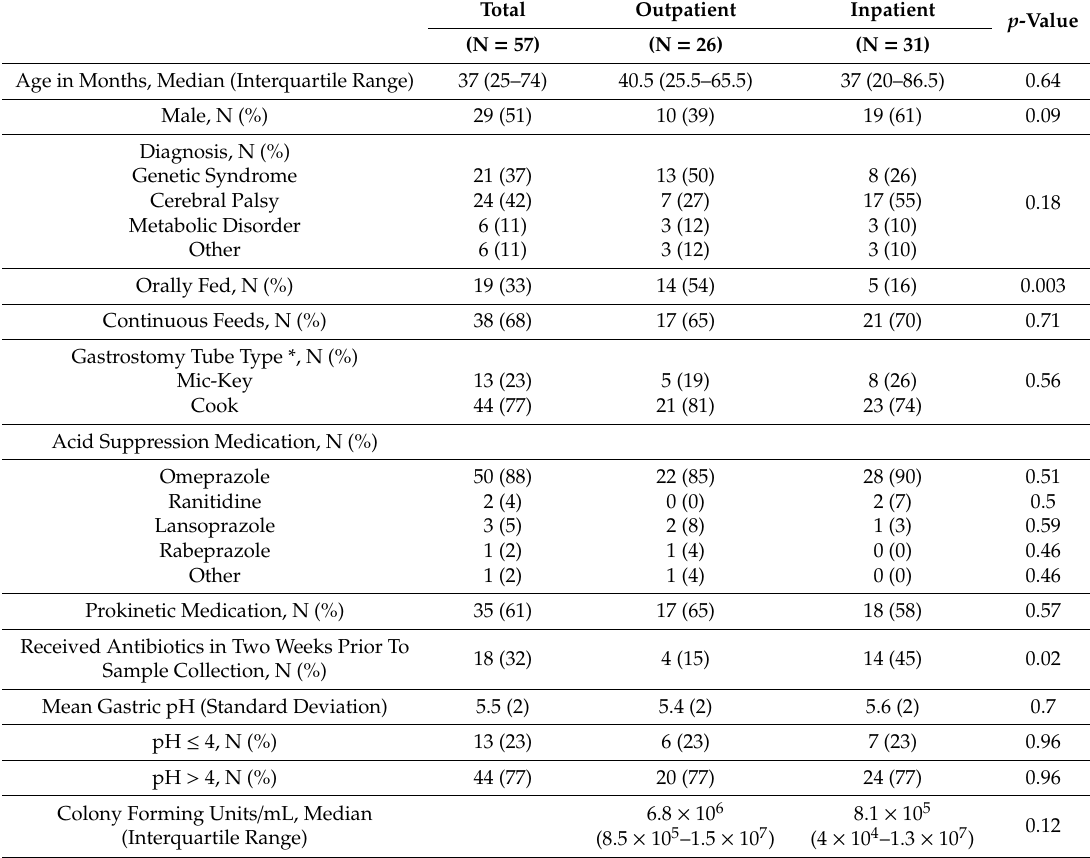
Table 1. Baseline Clinical